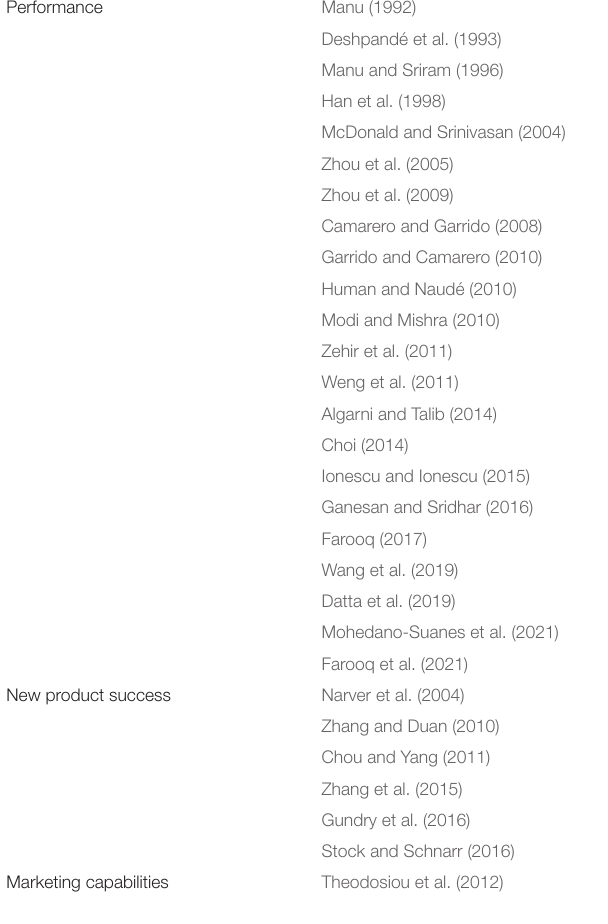
TABLE 3 | Principal results of innovation